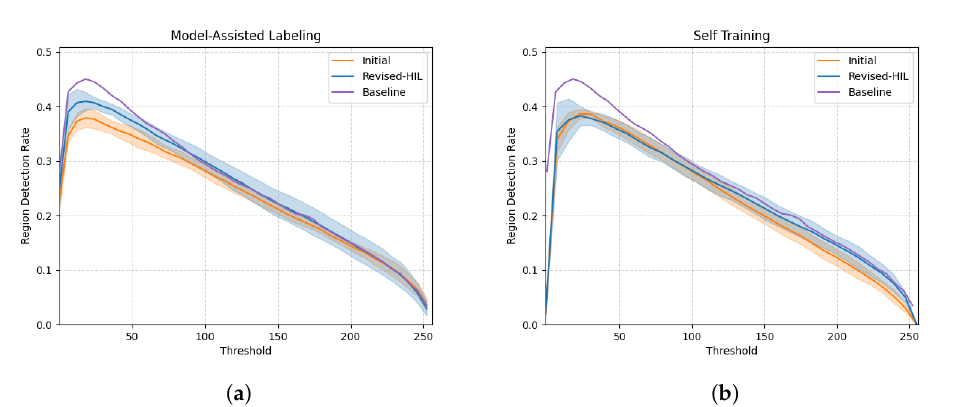
Figure 8. Illustration of the main results of both experiments. ( a ) shows the average RDR curves for the MAL experiment and ( b ) displays the average RDR curves for the self-training experiment. The variance of the average RDR curves is visualized as a shaded area around the curve. Table 3. The final scores (sum of the best RDR and the AUC) for each run of each experiment. For each run, the higher score is highlighted in